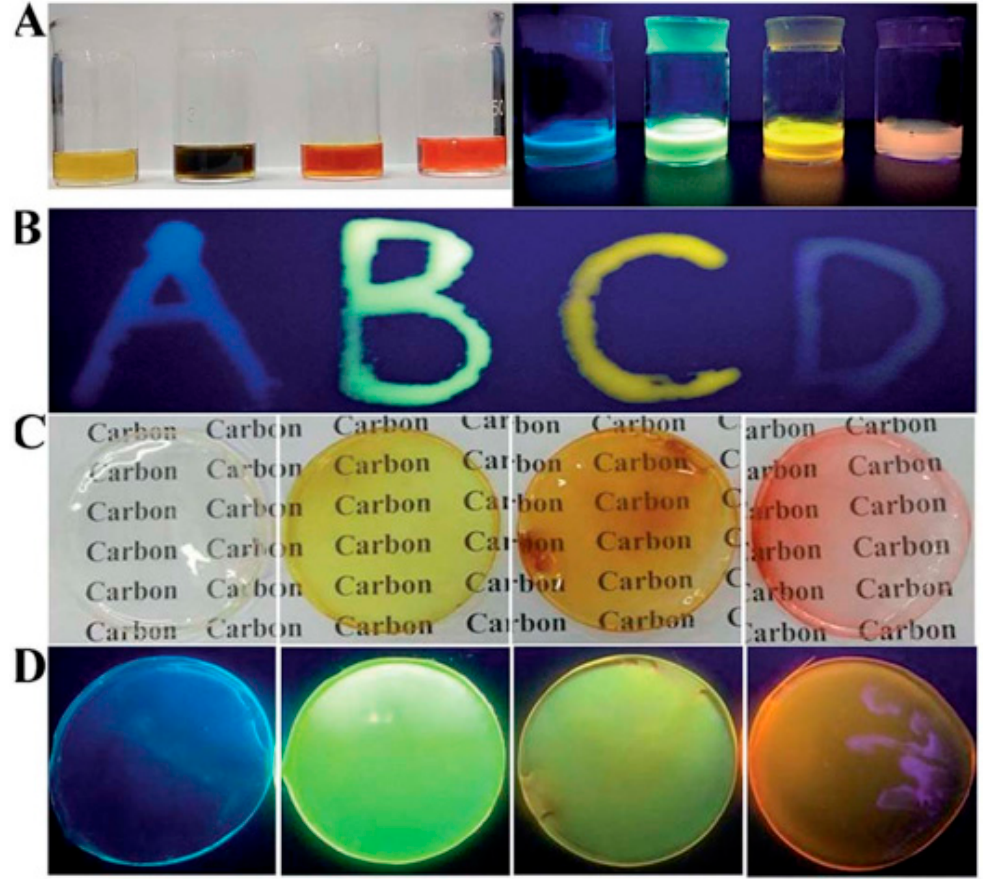
Figure 7. ( A ) Images of B-, G-, Y-, and O-CD/PVA solutions under daylight and UV light. ( B ) Pic- tures of four characteristics under UV light with B-, G-, Y-, and O-CD/PVA solutions as FL ink. ( C ) Images of B-, G-, Y-, and O-CD/PVA films under daylight. ( D ) Images of B-, G-, Y-, and O-CD/PVA films under UV light. Reprinted with permission from [89]. Copyright (2019) The Royal Society of Chemistry.